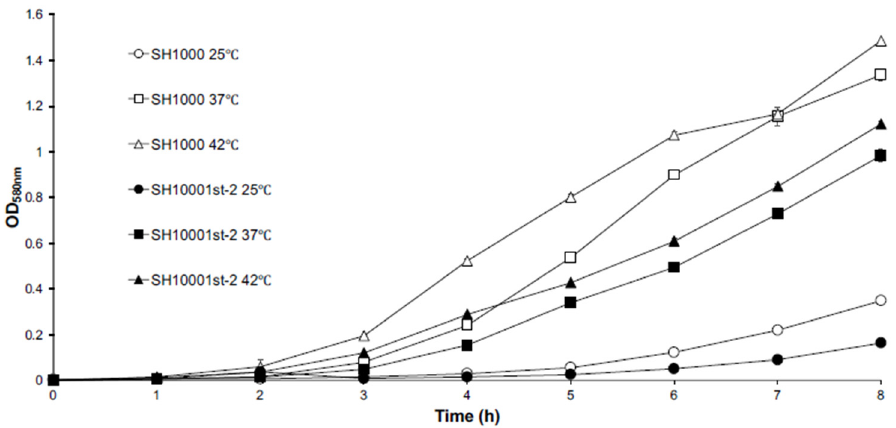
Figure 1. Growth curves of SH1000 (open symbols) and SH10001st-2 (closed symbols) at 25 °C ( , ) 37 °C ( , ), or 42 °C ( , ). All data shown are the mean of triplicate experiments and error bars represent the standard deviation.